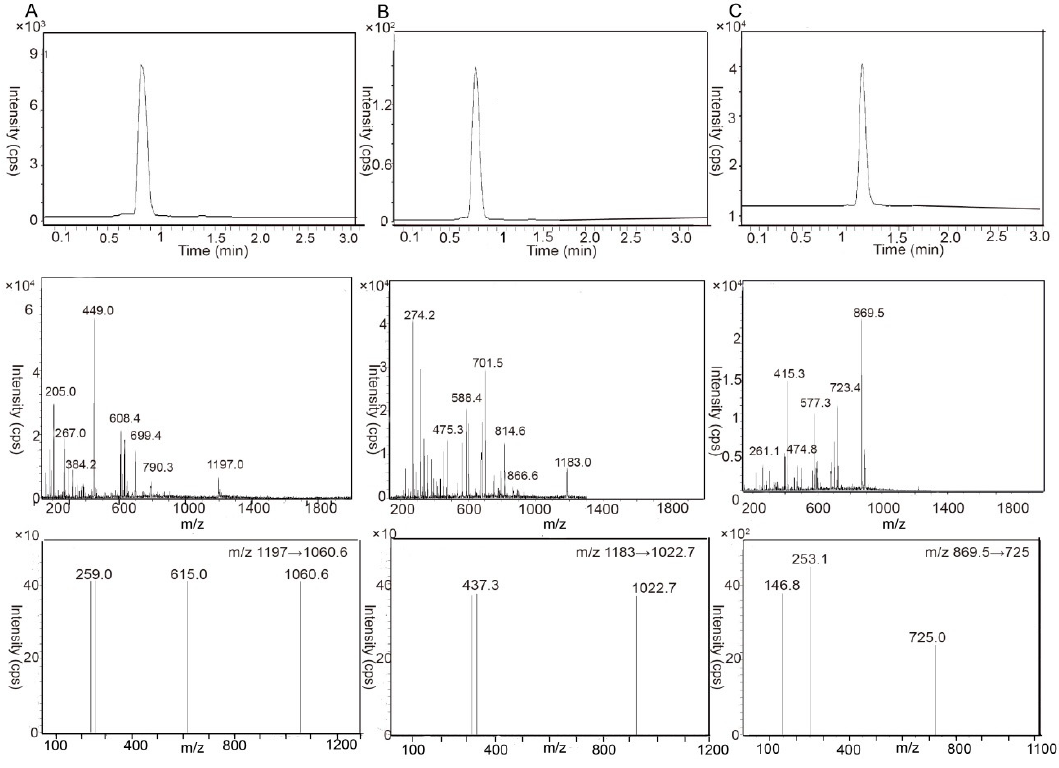
Figure 2. Bidirectional transport studies of capilliposide B (CAPB, A ), capilliposide C (CAPC, B ) at different initial drug concentrations (10, 20 and 40 μ g/mL). p < 0.05 (*), comparison with the 10 μ g/mL capilliposides （ CAPs ） group. The apparent permeability (P app , cm/s) values of CAPB and CAPC at 0, 45, 60 and 90 min ( C ). The P app (BA)/P app (AB) values of CAPB and CAPC were at different initial drug concentrations (10, 20 and 40 μ g/mL) ( D ). All results are expressed as mean ±S.D. (n = 3).